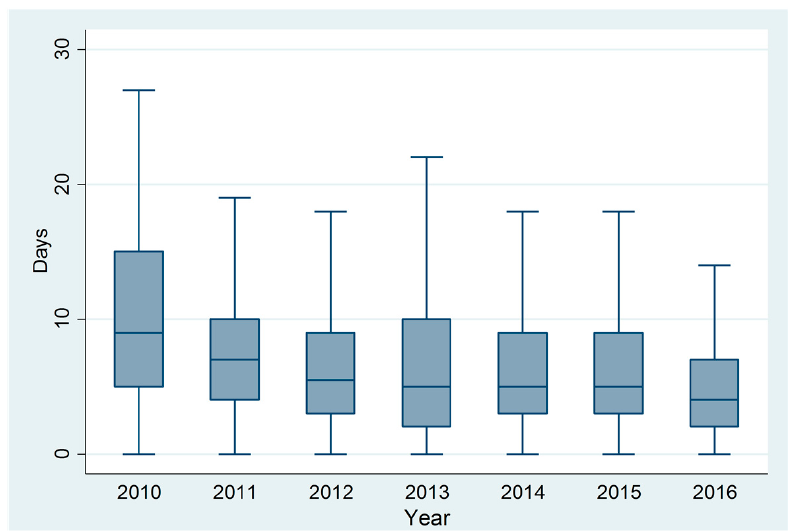
Figure 5. Days (median, IQR) between onset of illness and seeking medical care, 2010 to 2016.